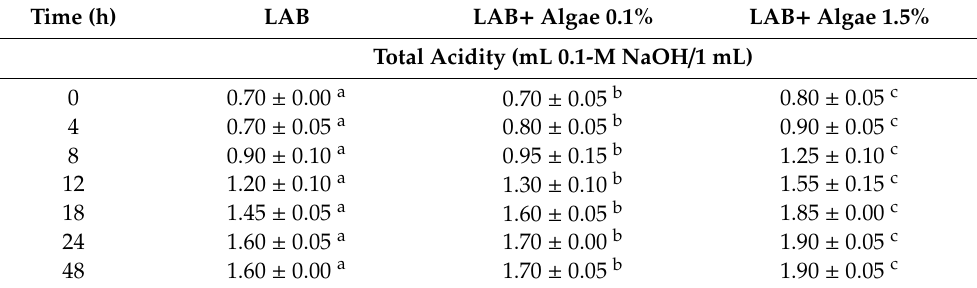
Table 2. E ff ect of algae Chlorella vulgaris on the total titratable acidity of Lactobacillus brevis ŁOCK 0980. Time